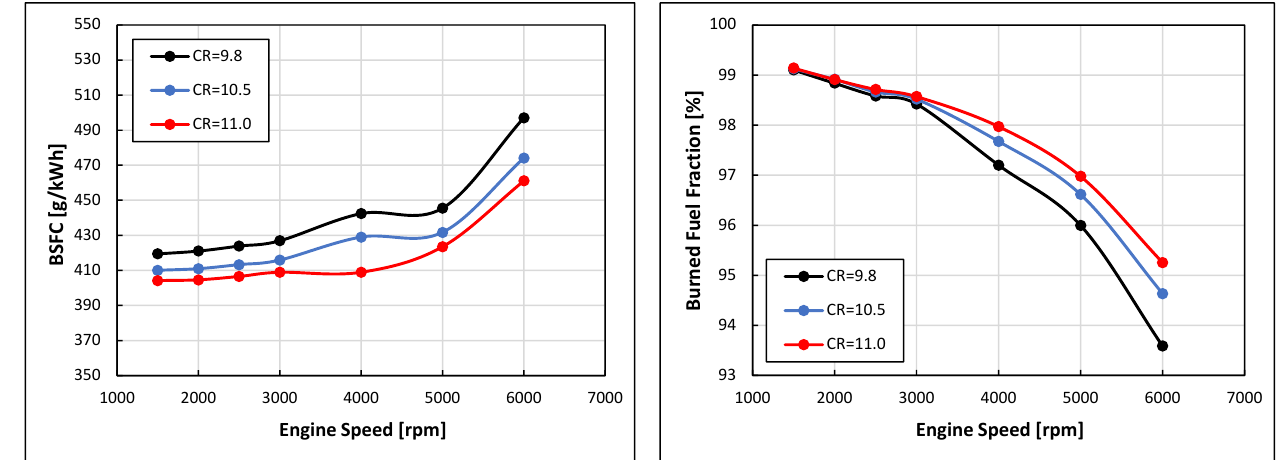
Figure 13. BSFC ( left ) and burned fuel fraction ( right ) for different compression ratios. ϕ = 1, WOT, no boost.